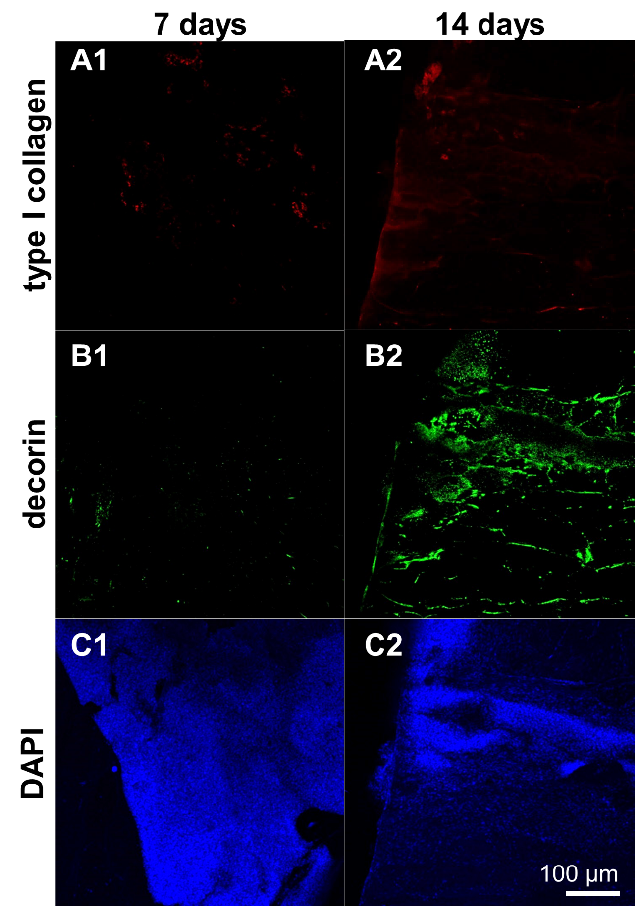
Figure 9. Protein expression of type I collagen and decorin by ligamentocyte sheets released from PGE-coated surfaces and seeded on embroidered scaffolds for 7 or 14 d. Type I collagen is depicted in red ( A1 , A2 ), decorin in green ( B1 , B2 ). Ligamentocyte nuclei were counterstained in blue using 4’,6-diamidino-2-phenylindole (DAPI) ( C1 , C2 ). A view on the sheet is shown by confocal laser scanning microscopy. Scale bar: 100 µ m ( A1 – C2